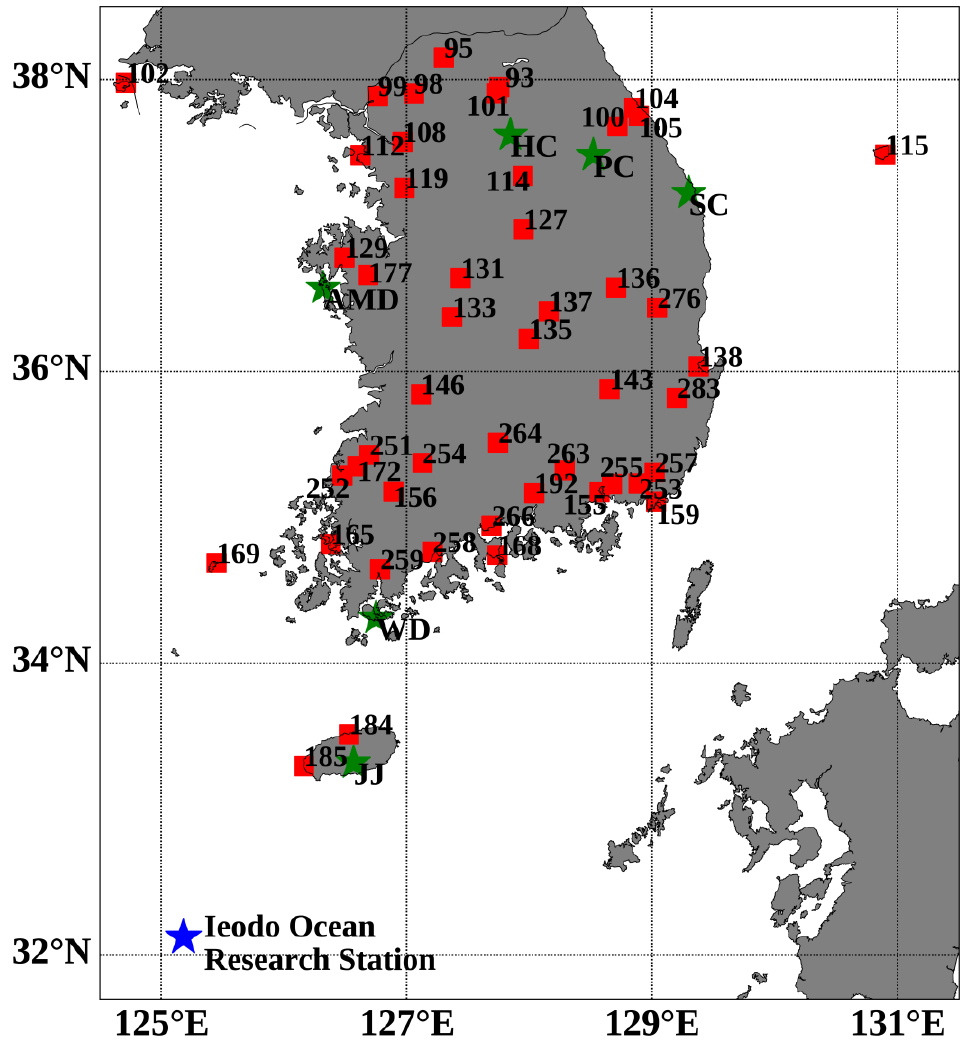
Figure 2. The distribution of in situ measurement stations over the Korean Peninsula, where the red rectangles indicate the Korea Meteorological Administration (KMA) Automated Surface Observing System (ASOS) stations; blue star and green stars denote the Ieodo Ocean Research Station operated by the Korea Hydrographic and Oceanographic Agency (KHOA) and flux towers operated by the National Institute of Forest Science (NIFoS), respectively.